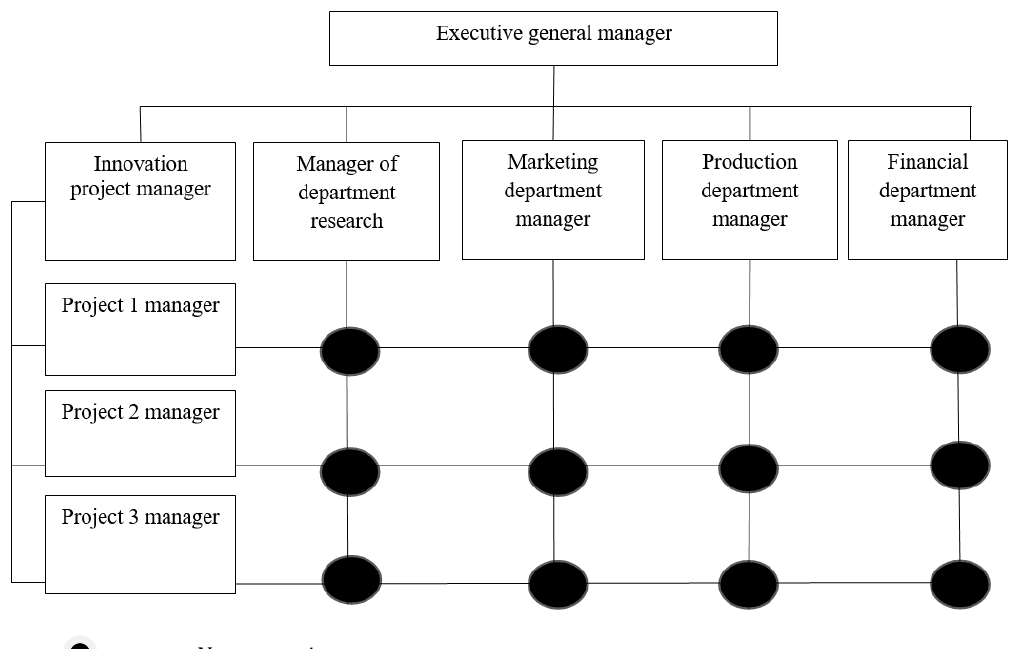
Figure 3: Project-matrix structure of organizing innovation activities at agro-industrial